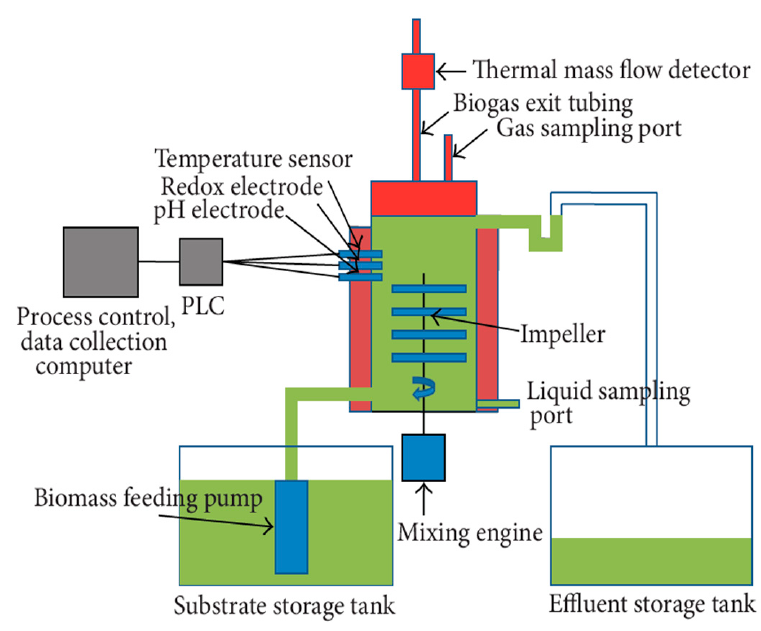
Figure 1. The schematic 2D diagram of the experimental setup.